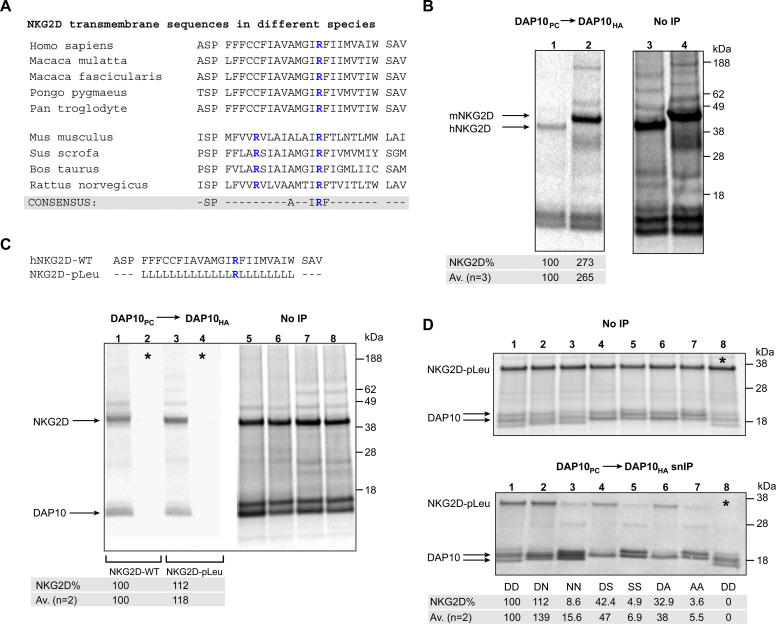
Structural Requirements for Assembly of DAP10 with NKG2D, a Type II TM Receptor(A) Sequences of TM domains and flanking segments for NKG2D in different species.(B) Human DAP10 assembly with human or mouse NKG2D (lanes 1 and 2, respectively). Complexes were isolated by two-step snIP utilizing PC and HA tags attached to DAP10, and associated NKG2D was quantitated.(C) Efficient assembly of DAP10 with NKG2D-pLeu in which the native TM domain was substituted with a polyleucine sequence containing a properly positioned arginine. Assembly of DAP10 with NKG2D proteins was examined by two-step snIP as in (B). The images shown are representative of two experiments.(D) Modification of the TM domain in NKG2D-pLeu does not alter the interaction between the TM arginine of NKG2D and the aspartic acid pair of DAP10. Images were analyzed as described in
Figure 2C for KIR-DAP12. SDS-PAGE was performed under reducing conditions.